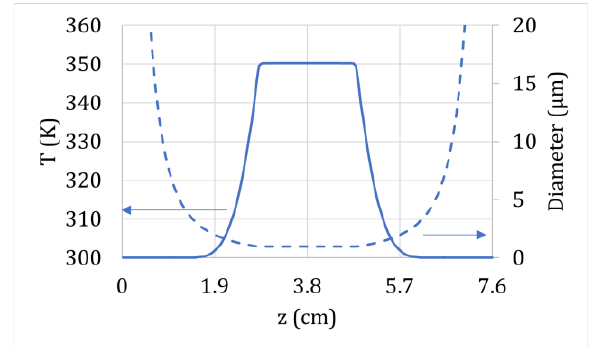
Fig. 1. Solid curve (left scale): temperature profile along the nanofiber and its tapers. Dotted curve (right scale): profile of the nanofiber and its tapers.